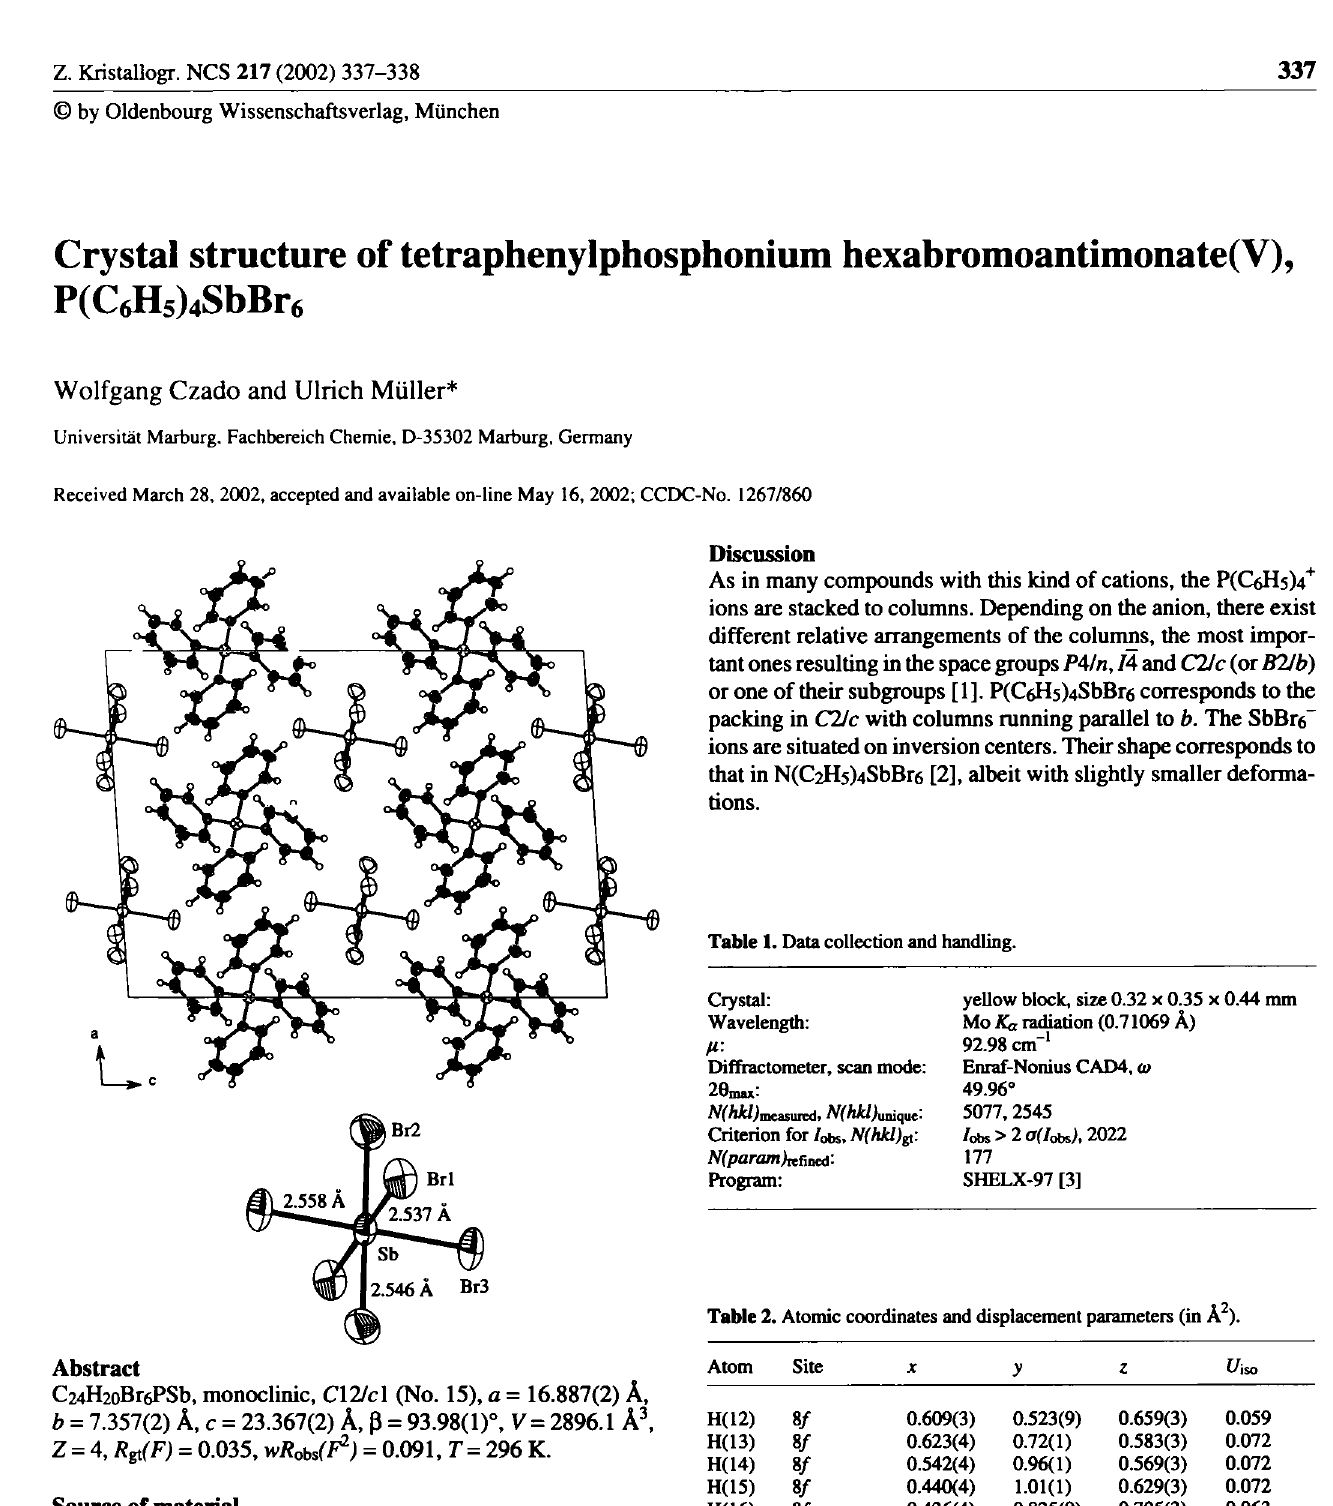
Table 2. Atomic coordinates and displacement parameters (in A 2